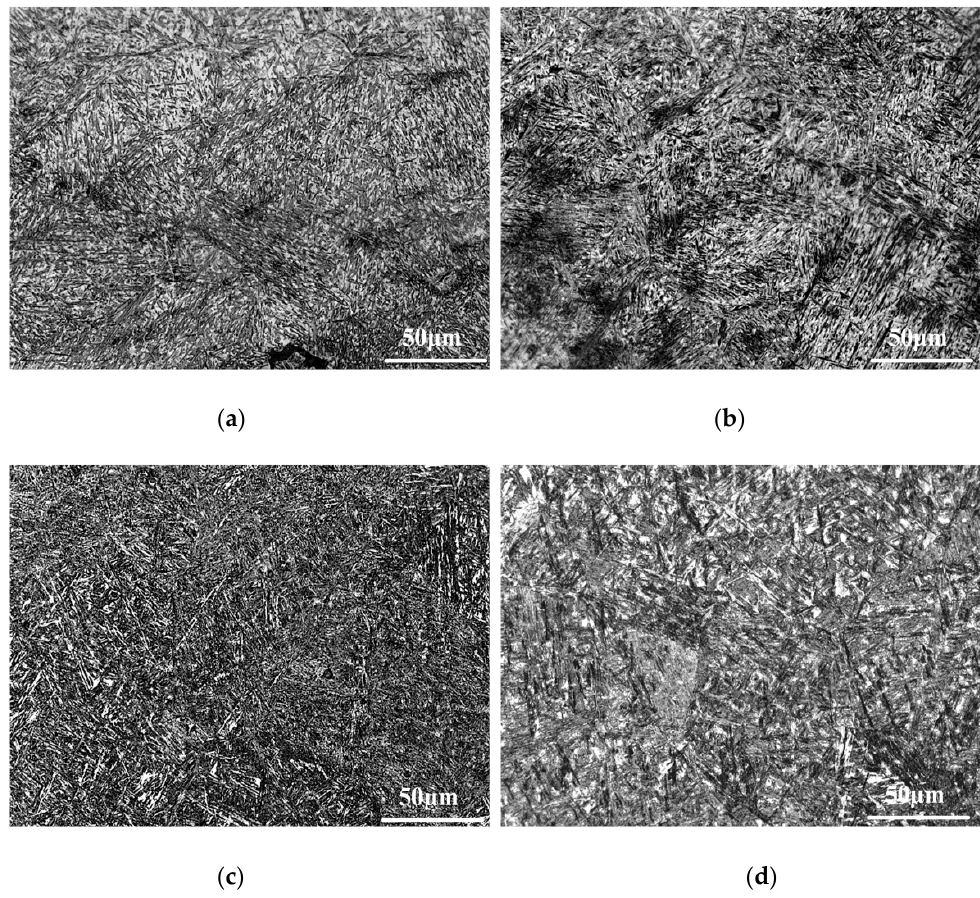
Figure 6. The structure of weld of 42CrMo4/38MnVS6 laser welded joint: ( a ) without preheat; ( b ) 100 °C; ( c ) 200 °C; ( d ) 300 °C.